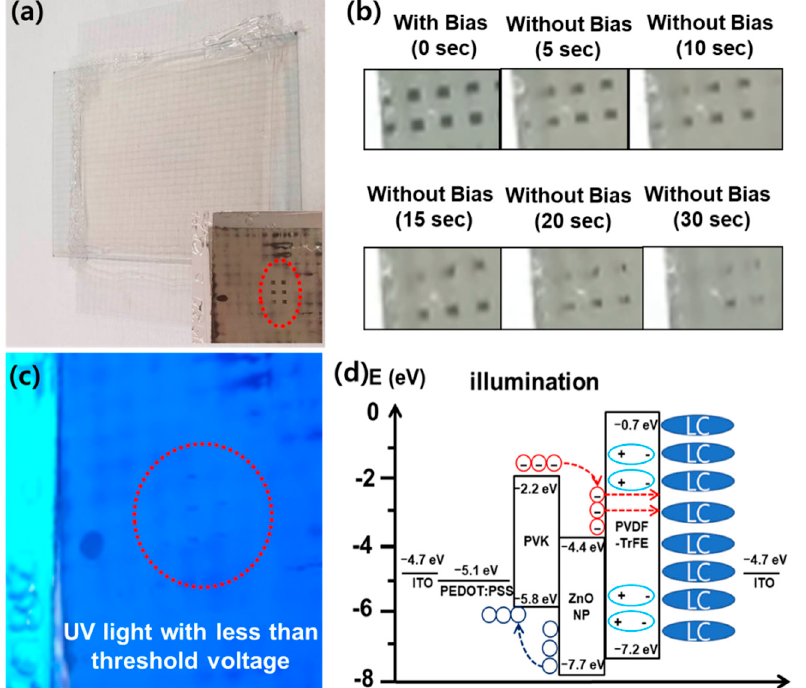
Figure 5. ( a ) Microscopy images of UV light-responsive memory devices without bias voltage. Inset showed turn-on state of UV light-responsive memory devices. ( b ) Microscopy images of UV light-responsive memory devices after external voltage turn-off with different time periods. ( c ) The microscopy images of UV light-responsive memory devices under UV exposure. ( d ) Energy band diagram of UV light-responsive memory devices under UV